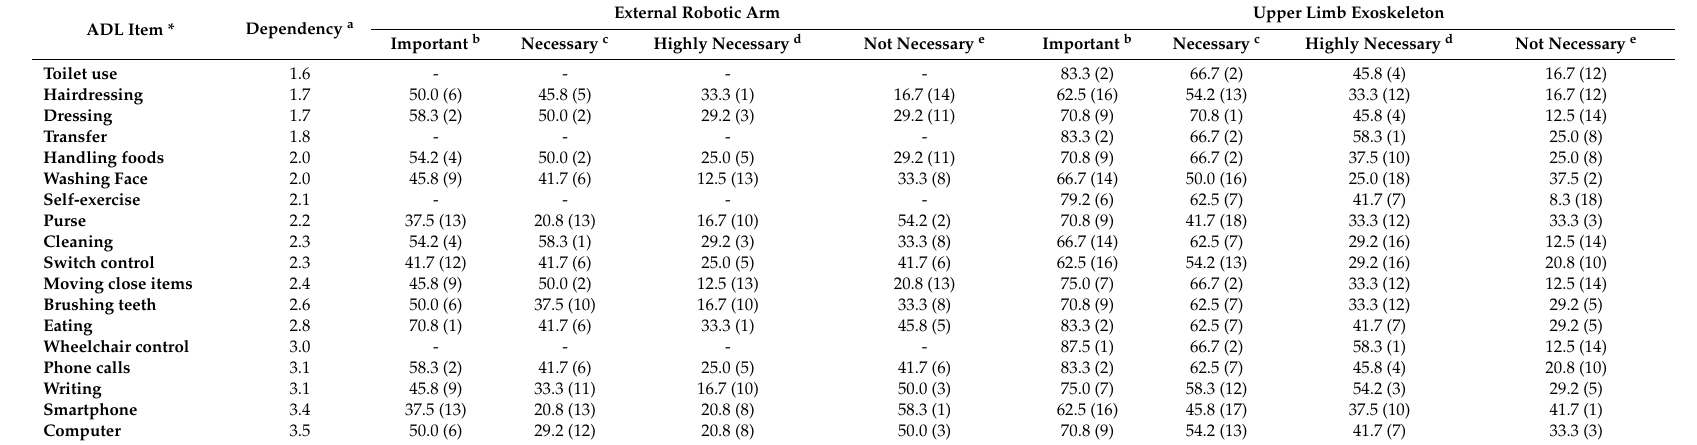
Table 3. Dependency, importance, and necessity for assistive robots in the bilateral impairment group ( n =